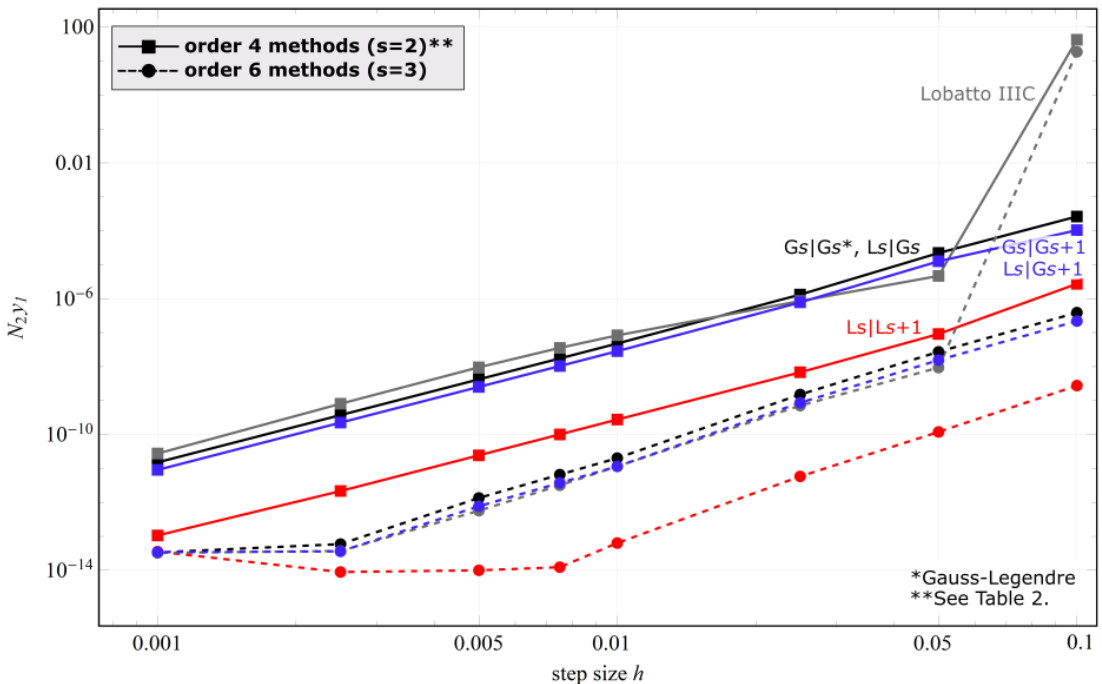
Figure 4. The errors of different methods (as the 𝐿 2 norm) vs. the step size in Example 4 (log–log scale). Method accuracy is provided in Table 2.